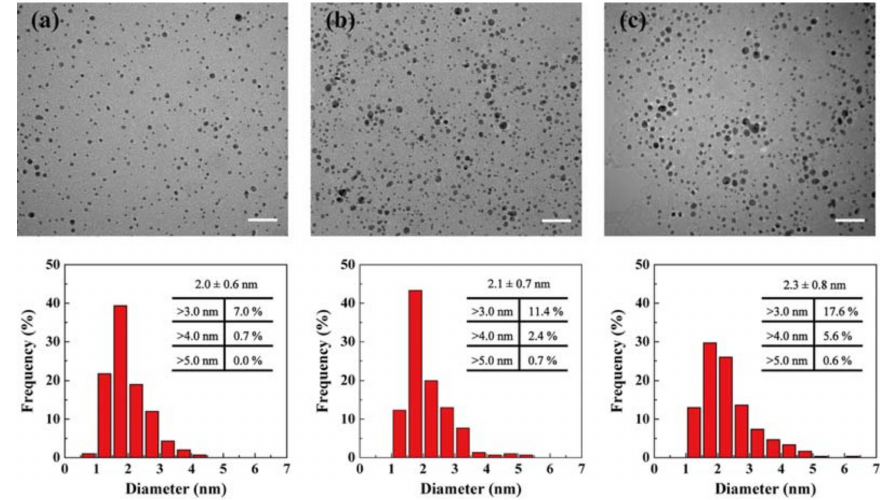
Figure 2. TEM images and the corresponding size distribution histograms of the formed Au NPs in Ac-Au 15 ( a ), Ac-Au 30 ( b ), and Ac-Au 45 ( c ) dendrimers. Scale bars: 20